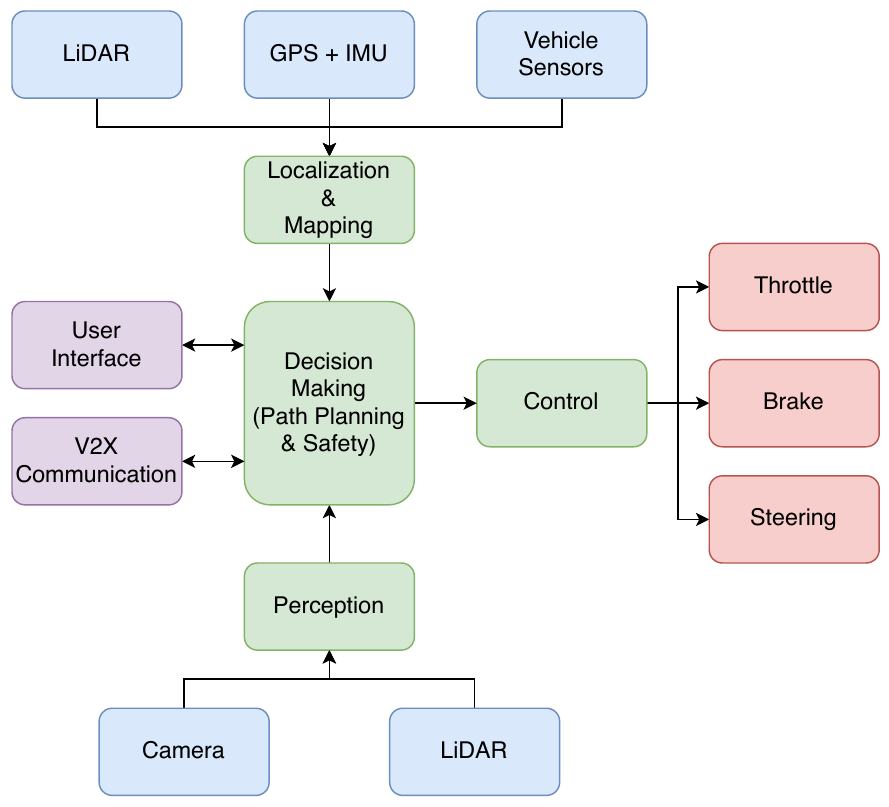
Figure 2. Proposed software